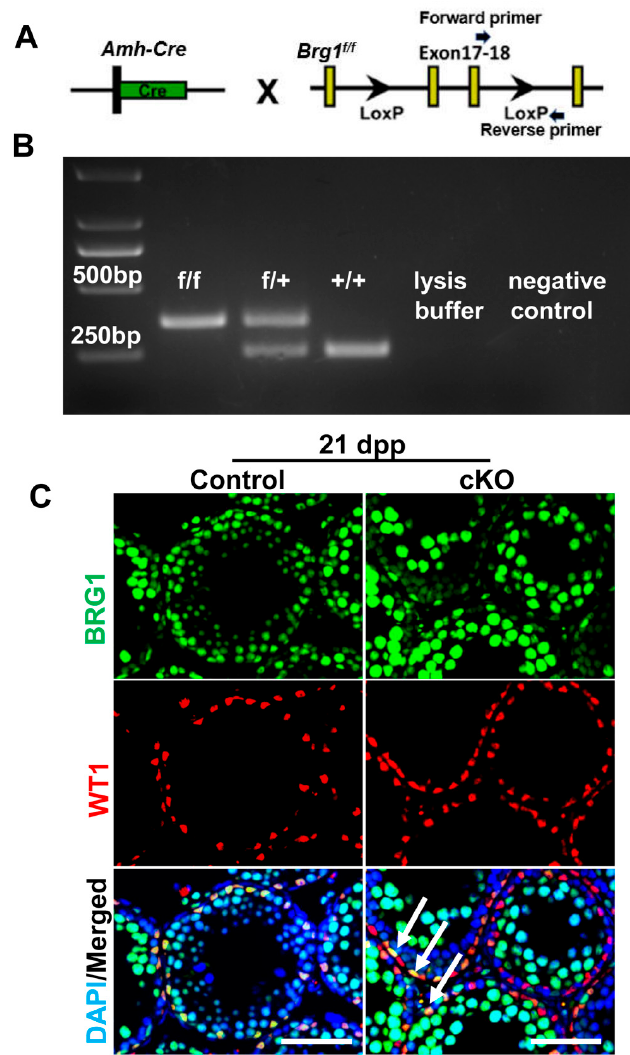
Figure 2. Partial deletion of Brg1 in Sertoli cells by Amh-Cre mice from Jackson Lab. ( A ) Strategy to delete Brg1 in Sertoli cells by Amh-Cre (Jackson) mice. Arrows indicate position of forward and reverse primers for genotyping analyses to detect Brg1 floxed alleles. ( B ) An example of genotyping on offspring from Brg1 f/+ mice crossed with Brg1 f/+ ; Amh-Cre. PCR on lysed mouse tail snips amplified the Brg1 genomic locus to generate a 380 bp DNA band from the mutated region, containing a loxP site or a 250 bp band from wildtype locus. +/+: wildtype; f/+: heterozygous; f/f: homozygous. ( C ) BRG1 and WT1 proteins were examined by IHF in testicle sections from Brg1 cKO mice ( Brg1 f/f ; Amh-Cre ) and their littermate controls at 21 dpp. Arrows point to WT1+ Sertoli cells with BRG1 expression. Scale bars, 100 μ m.